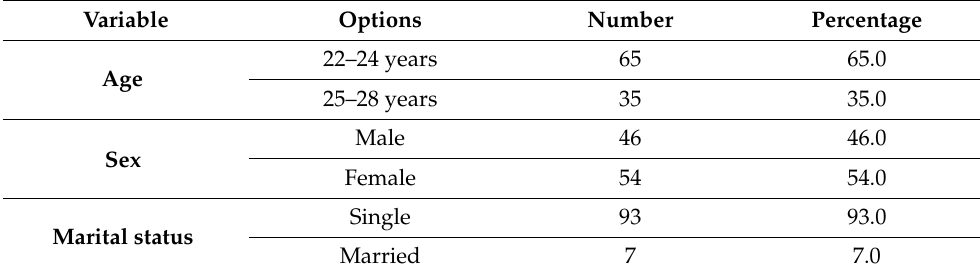
Table 1. Distribution of the study participants according to the demographic variables.